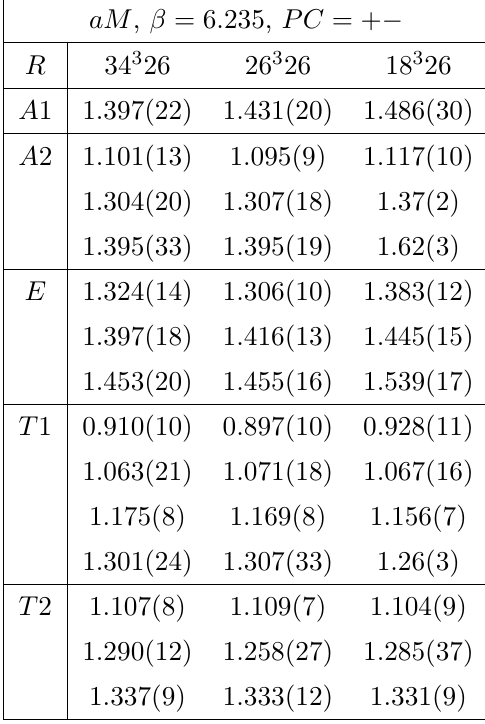
Table 5 . Finite volume check on glueball masses with P = + and C = − at β = 6 . 235 on the lattices shown. Where possible the masses are extracted from the same initial time and so are not always the same as our best mass estimates listed in other